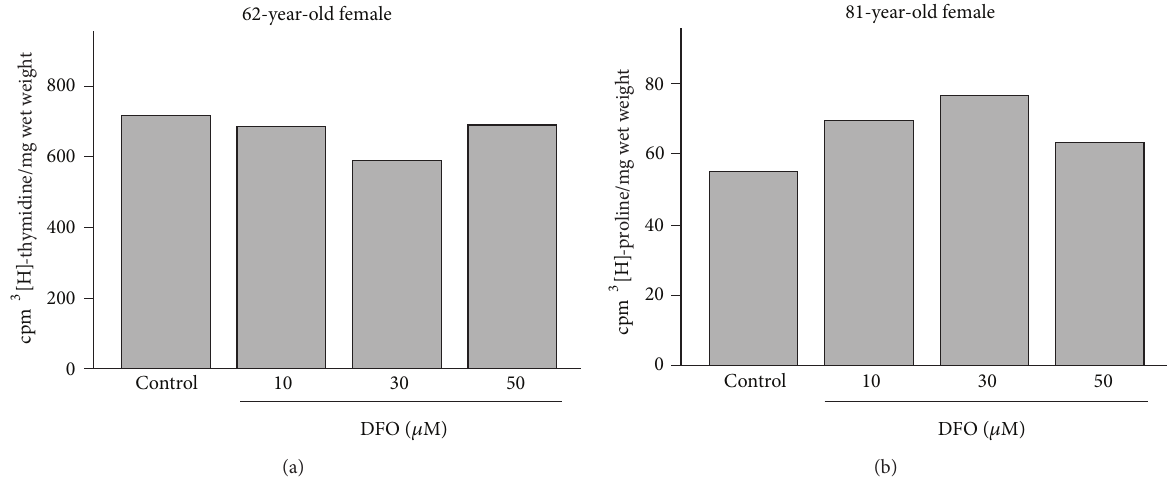
Figure 1: Representative analyses of 3 [H]-thymidine incorporation (a) and 3 [H]-proline uptake (b) into OA articular cartilage explants in the absence and presence of 10–50 𝜇 M